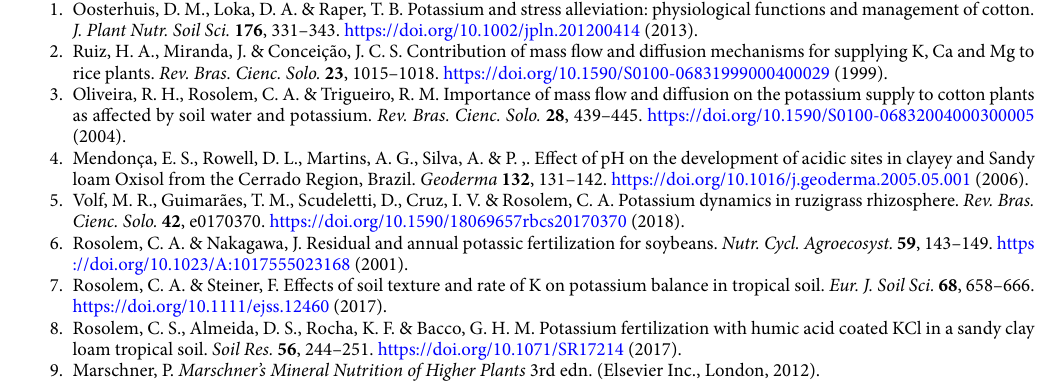
where KUE is the potassium use efficiency; Y 116K is the yield of the treatment fertilized; Y 0K is the yield of the treatment unfertilized; Y 116K+RZ represents the yield of all fertilized treatments with ruzigrass (RZ) (116 K on RZ; 58 K on RZ + 58 K on C and 116 K on C + RZ); Y 0+RZ is the yield of unfertilized treatment with ruzigrass; C is cotton and RZ is ruzigrass. Results were expressed as kg of fiber produced per kg of K applied. After testing for homogeneity and normality, data were submitted to ANOVA. The experiment was arranged in a complete randomized block design with three fixed factors (K management, cotton cultivar, and years) and five replicates. The data were analyzed with three-way analysis of variance. Since no significant difference was observed for cotton cultivars, results were averaged across cultivars (Sup. 1) and Tukey’s test ( P < 0.05) was used to determine significant differences. Pearson correlation coefficients (Minitab, State College, Pennsylvania) were determined between cotton growth, yield components and fiber quality parameters.